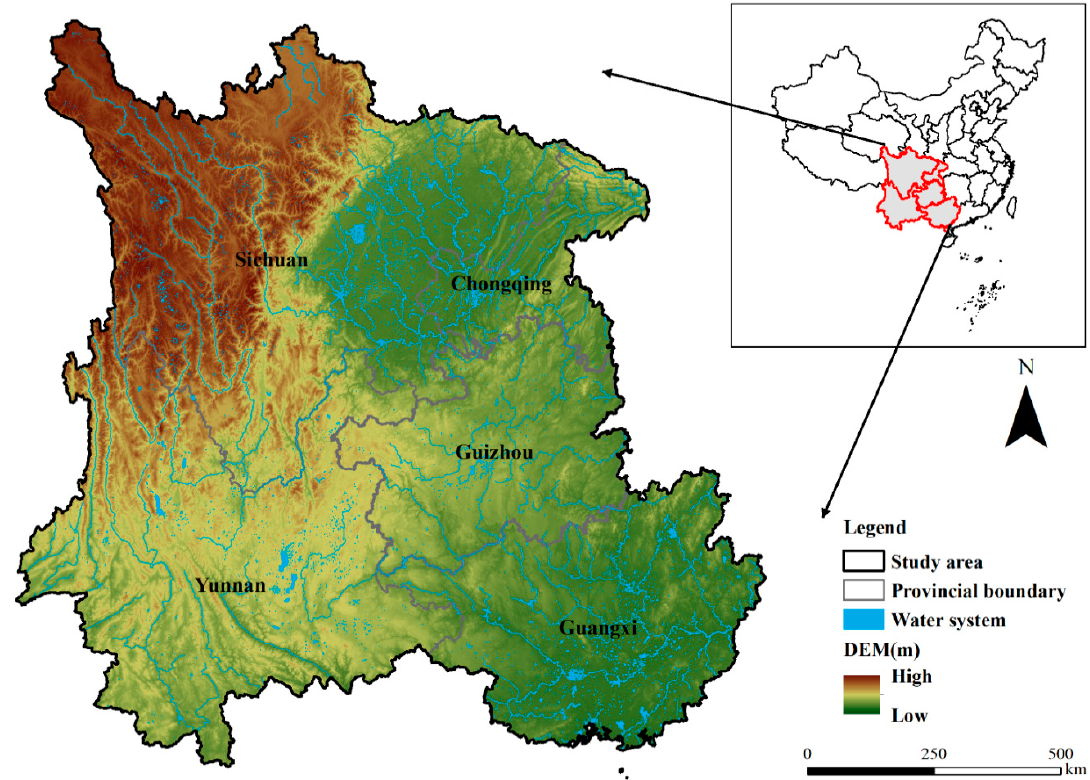
Figure 1. Location of study area in Southwest China (Note: The digital elevation model is abbreviated as DEM).